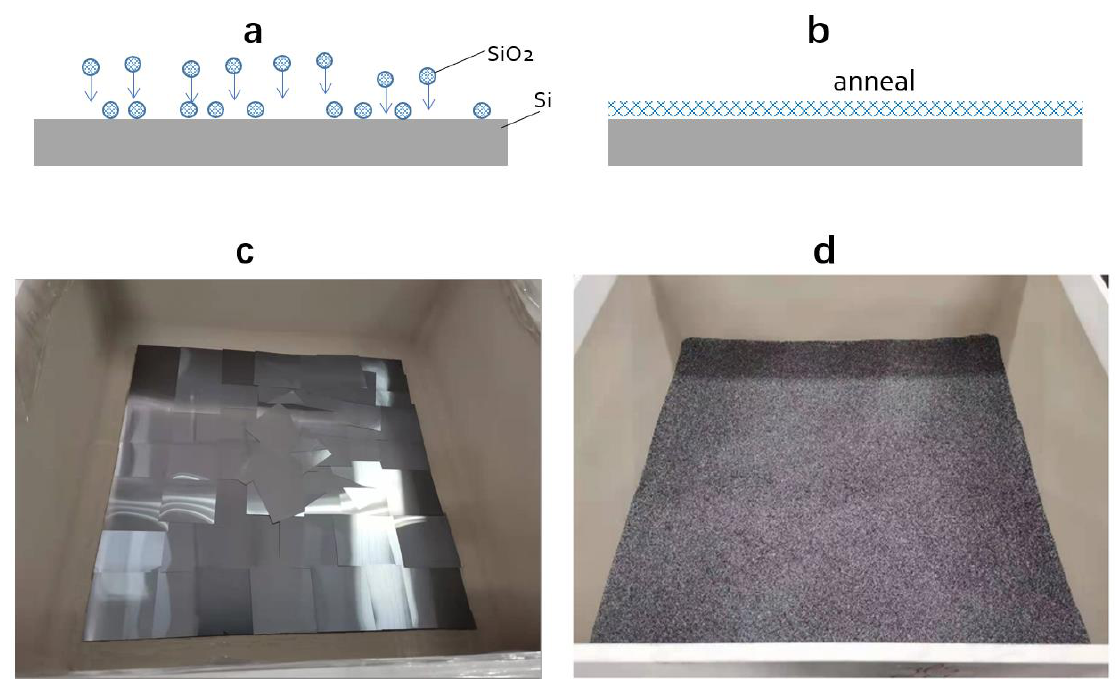
Figure 1. Preparation of Mc-Si before charging. ( a ) Electrophoretic deposited quartz; ( b ) Depositional quartz anneal; ( c ) Paste the wafers; ( d ) Filled silicon particles.